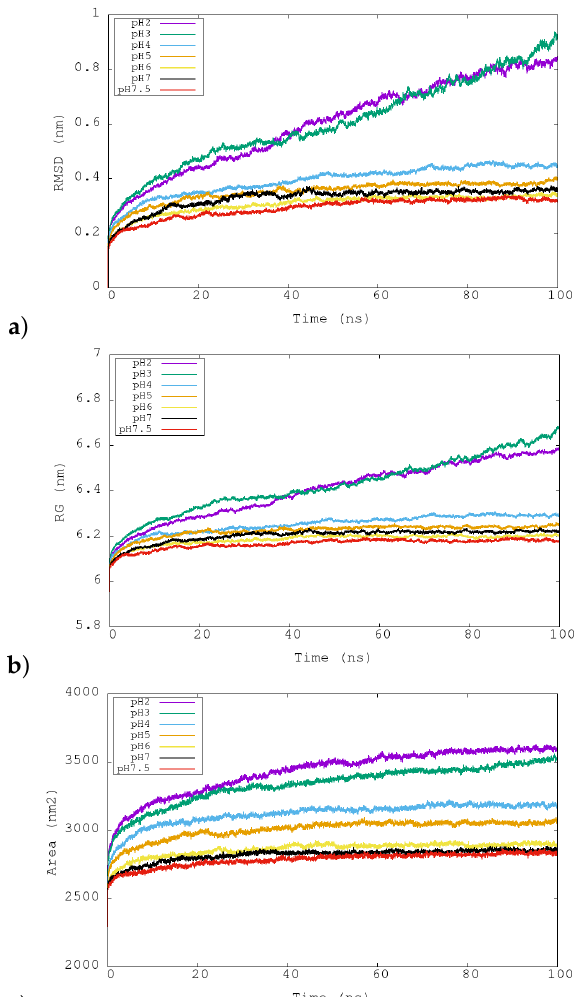
Figure 3. Representation of the temporal evolution of structural properties of urease in the molecular dynamics simulations at pH 2, 3, 4, 5, 6, 7 and 7.5. ( a ) Root-mean-square deviation (RMSD) for the total